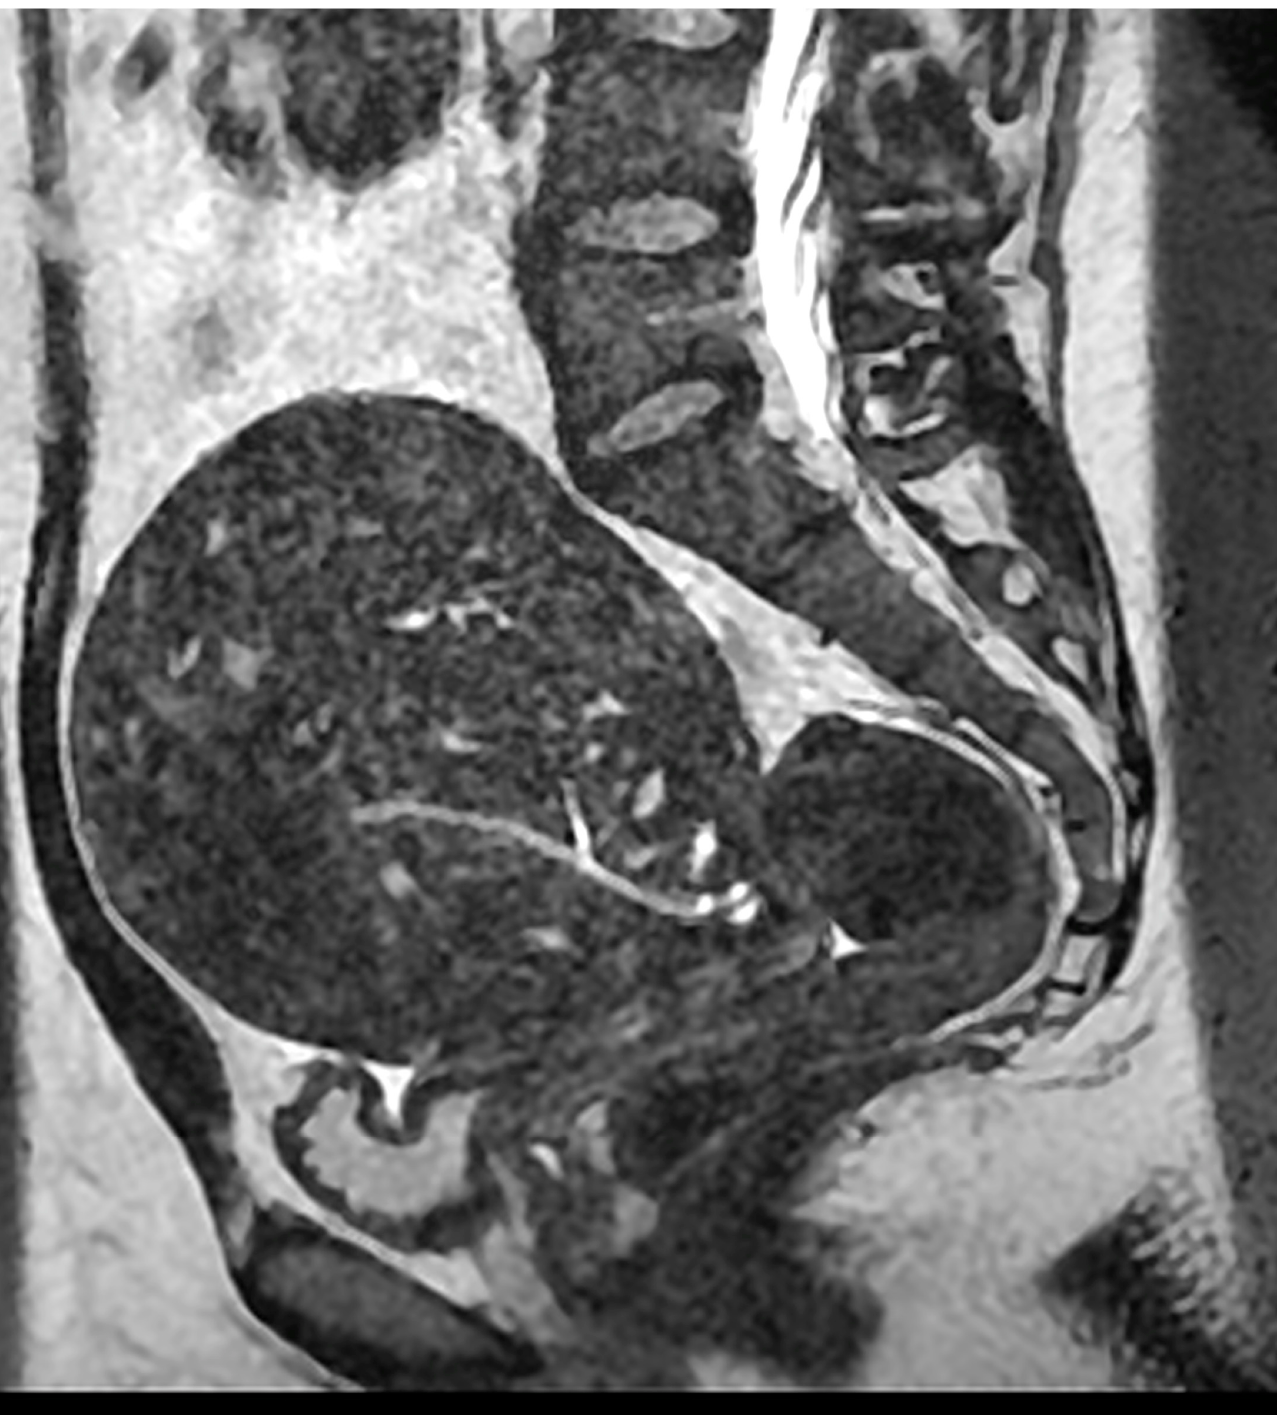
Figure 3. Magnetic resonance imaging (MRI) sagittal T2-weighted MRI showing a globular uterus containing multiple endometrial foci related to deep diffuse internal adenomyosis. Reproduced with permission from Habiba et al. (2020).